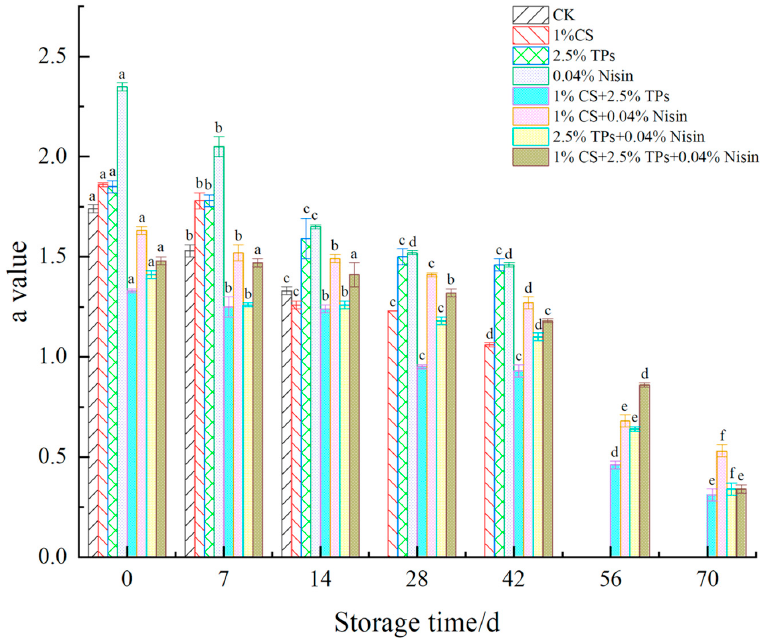
Figure 5. Effects of compound preservatives on the “a value” of plant-based meat. a–f Values with different superscripts in the same preservative indicate significant differences ( p < 0.05). CS, chitosan; TP, tea polyphenols; CK, control group.